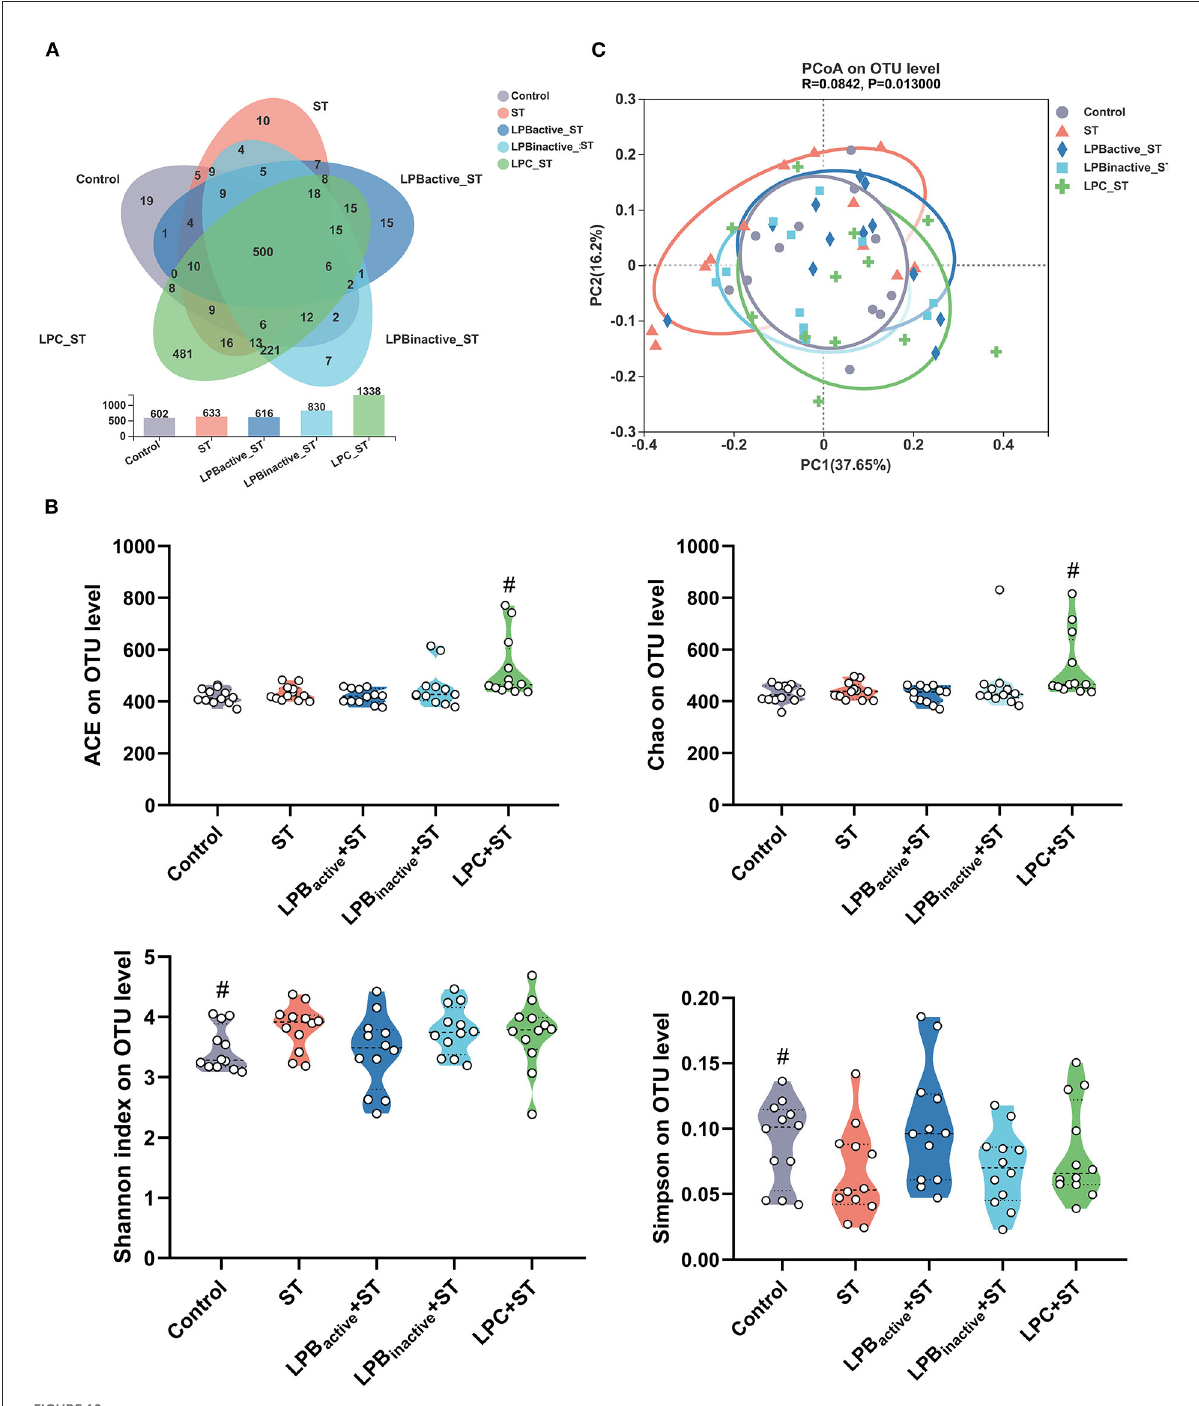
FIGURE10 Analysis of the diversity of gut microbiota. (A) Venn diagram indicating the operational taxonomic units (OTUs) in each group. (B) The indexes representing α diversity at the OTU level. (C) The β -diversity displayed in a principal component analysis (PCA) scatterplot. The data shown as mean ± SEM were analyzed by one-way ANOVA and Tukey’s test ( N = 12 in each group). # Indicates the significance compared to ST group: # p <